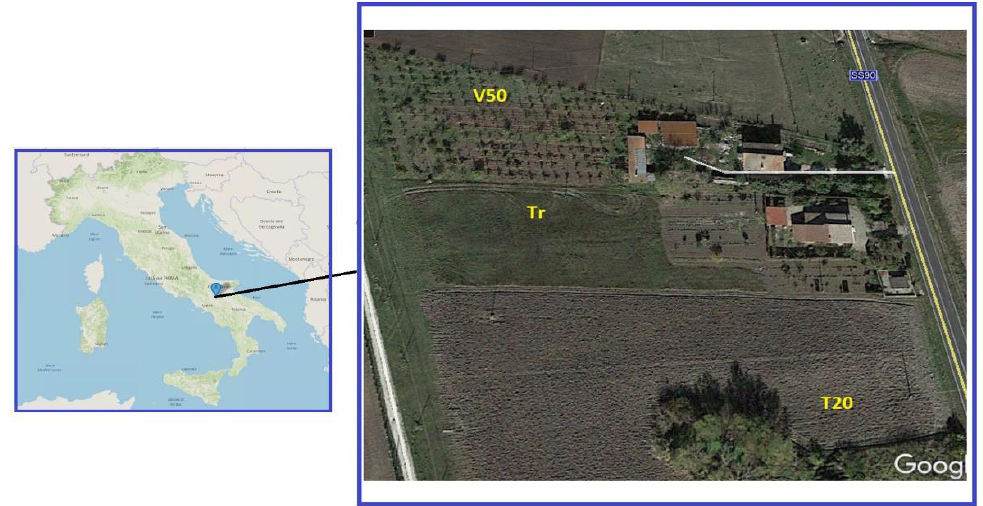
Figure 1. Map localization and satellite image with the area of study described in the present work. Images adapted from www.tuttocitta.it ( left ) (accessed on 10 August 2021) and Google Earth ( right , Google, Maxar Technologies).